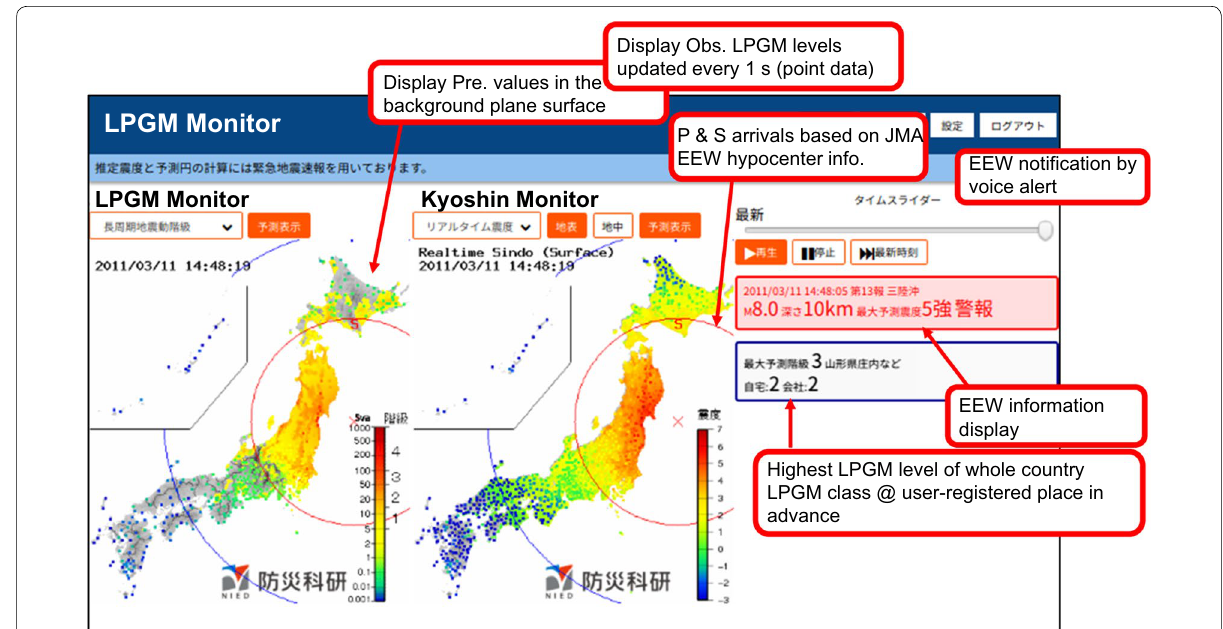
Fig. 12 Long-Period Ground Motion Monitor (left) with the intensity scale for long-period ground motions and Kyoshin Monitor (right) with the JMA seismic intensity scale reproducing the 2011 Tohoku